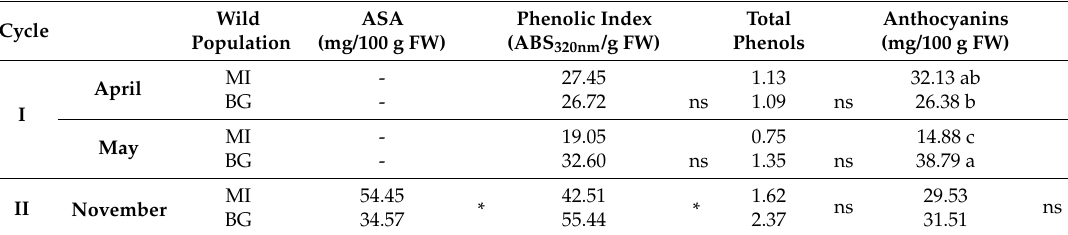
Table 3. Ascorbic acid (ASA), phenolic index, total phenols, and anthocyanin content in MI and BG hedge mustard wild populations ( n =